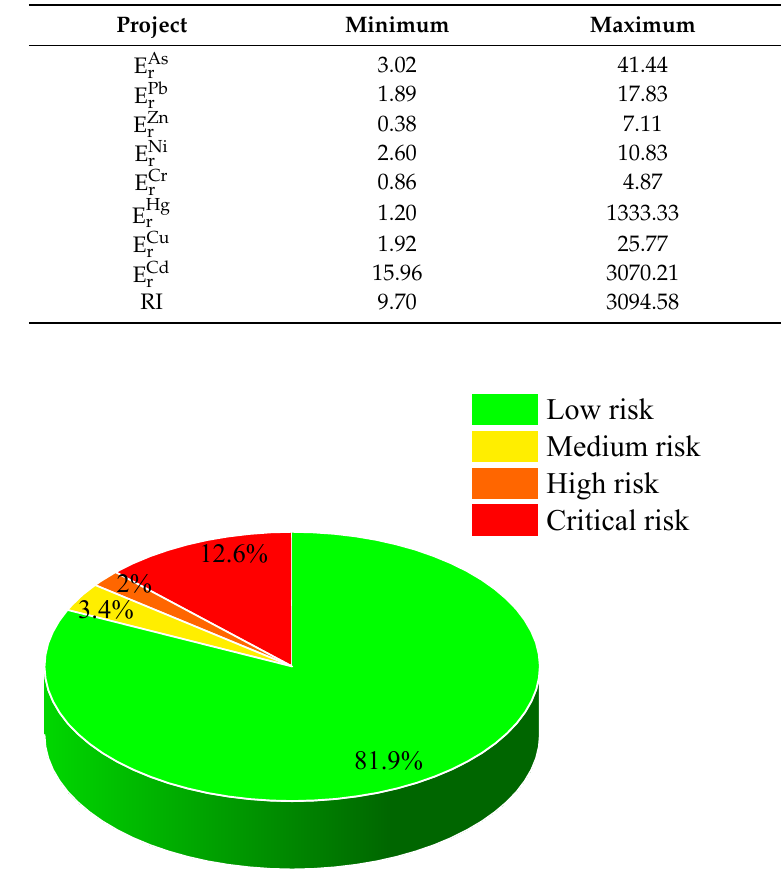
Figure 5. Pie chart of potential ecological risk distribution.